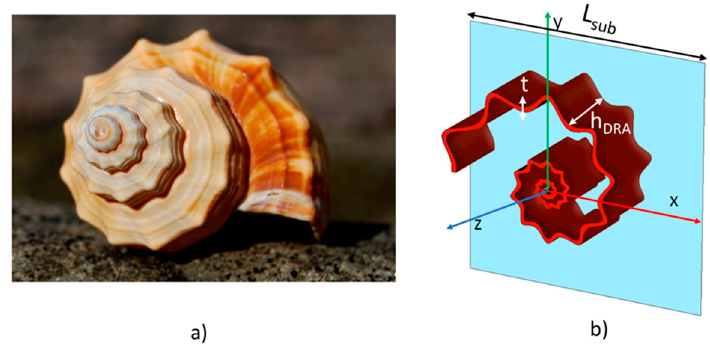
Figure 1. ( a ) Picture of a Button snail Modulus modulus (spiral seashell). ( b ) 3D sketch of the Spiral shell Dielectric Resonator Antenna (DRA).